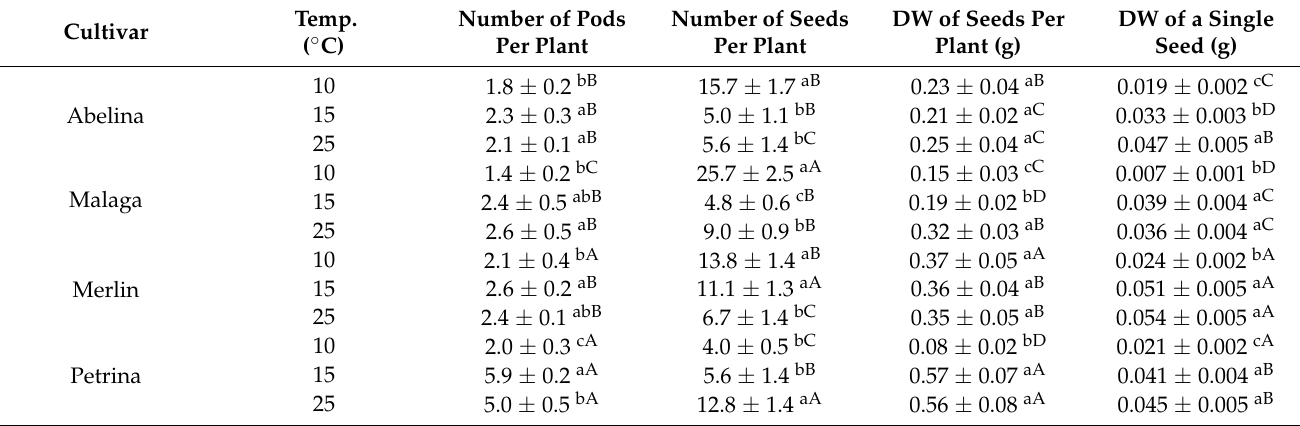
Values represent means ( n = 10) ± SE. The values within columns for each cultivar followed by the same lowercase letter do not differ significantly, while values within columns for each combination cultivar/germination temperature followed by an uppercase letter do not differ significantly according to Duncan’s multiple range test ( p <